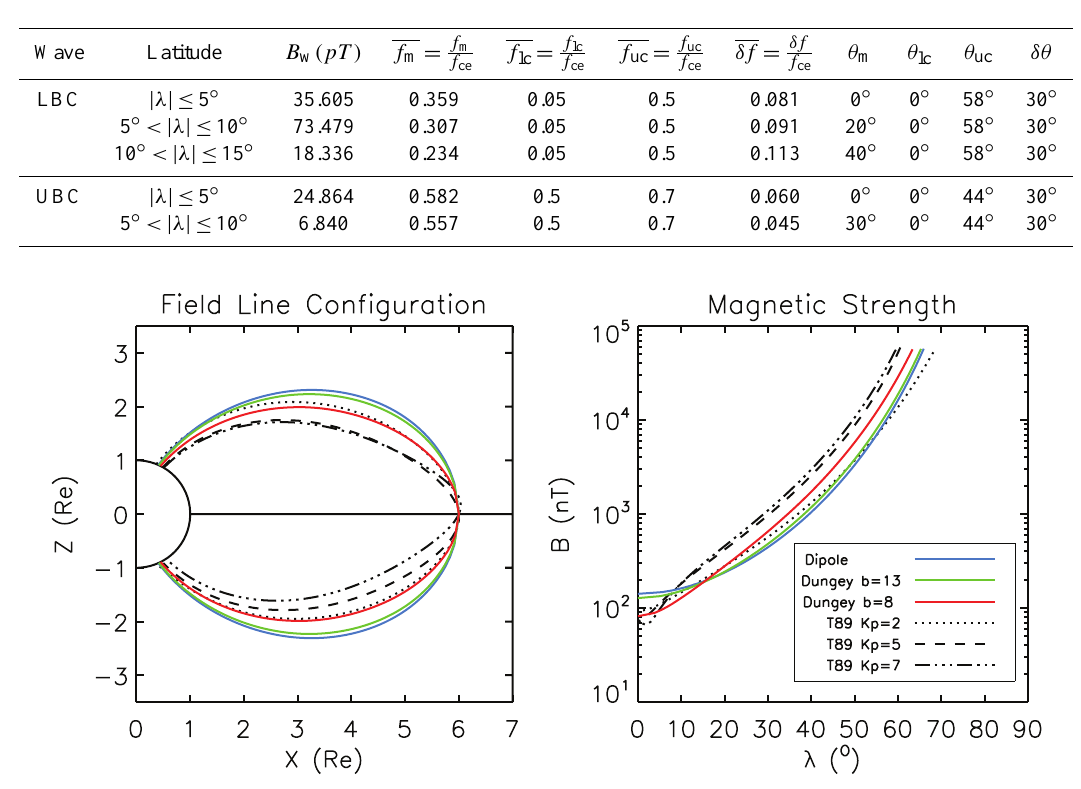
Table 1. Parameters of nightside chorus waves at L = 6 based on CRRES data.